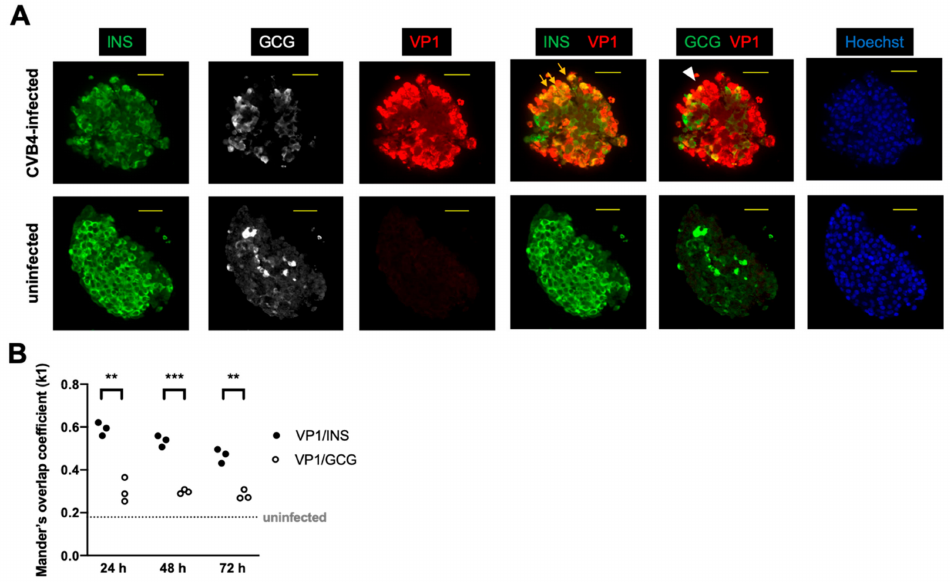
Figure 1. Immunostaining of stem cell-derived β (SC- β ) cells revealed abundant insulin (INS)- and glucagon (GCG)-positive cells with viral protein (VP1) predominantly colocalizing with INS. ( A ) The colocalization of green and red is shown as yellow. Arrows show examples of colocalization between VP1 and INS, and the arrowhead shows colocalization between VP1 and GCG. A representative cell cluster from each condition at 48 h post-infection with coxsackie B virus (CVB)4 (or control uninfected) is shown. INS = green, GCG = white or green, VP1 = red, Hoechst (DNA stain) = blue. Scale bar = 50 µ m. ( B ) Mander’s overlap coe ffi cients ( k1 ) for VP1 and INS and for VP1 and GCG in infected cells are shown at the indicated time points following infection. VP1 and INS colocalized more frequently than VP1 and GCG. (** p < 0.01; *** p < 0.001, multiple t -test). The coe ffi cient was significantly lower for uninfected controls for which the median value is shown as the horizontal dashed line ( p < 0.0001, Mann–Whitney test). Each point represents one field of